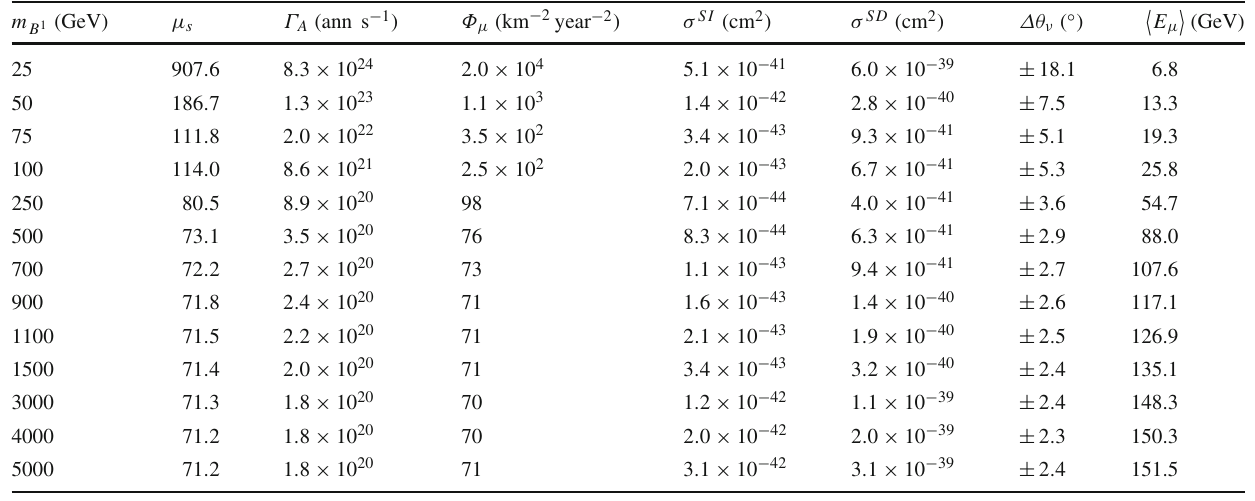
several values of the B 1 mass. The last two columns show the median angular resolution and the muon mean energy at the detector